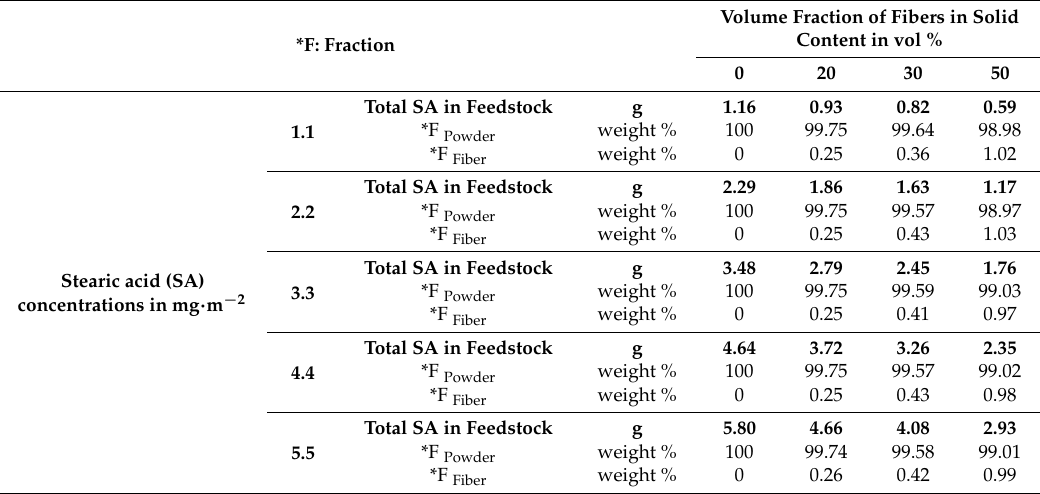
Table 3. The stearic acid quantities based on BET measurements for various feedstocks, and the weight fractions for powder and fibers. *F: Fraction